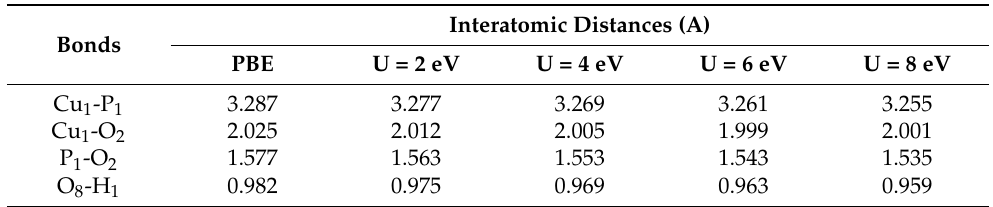
Table 2. Selected average bond lengths (Å ) of copper pyrophosphate dihydrate material calculated with PBE and PBE+U.